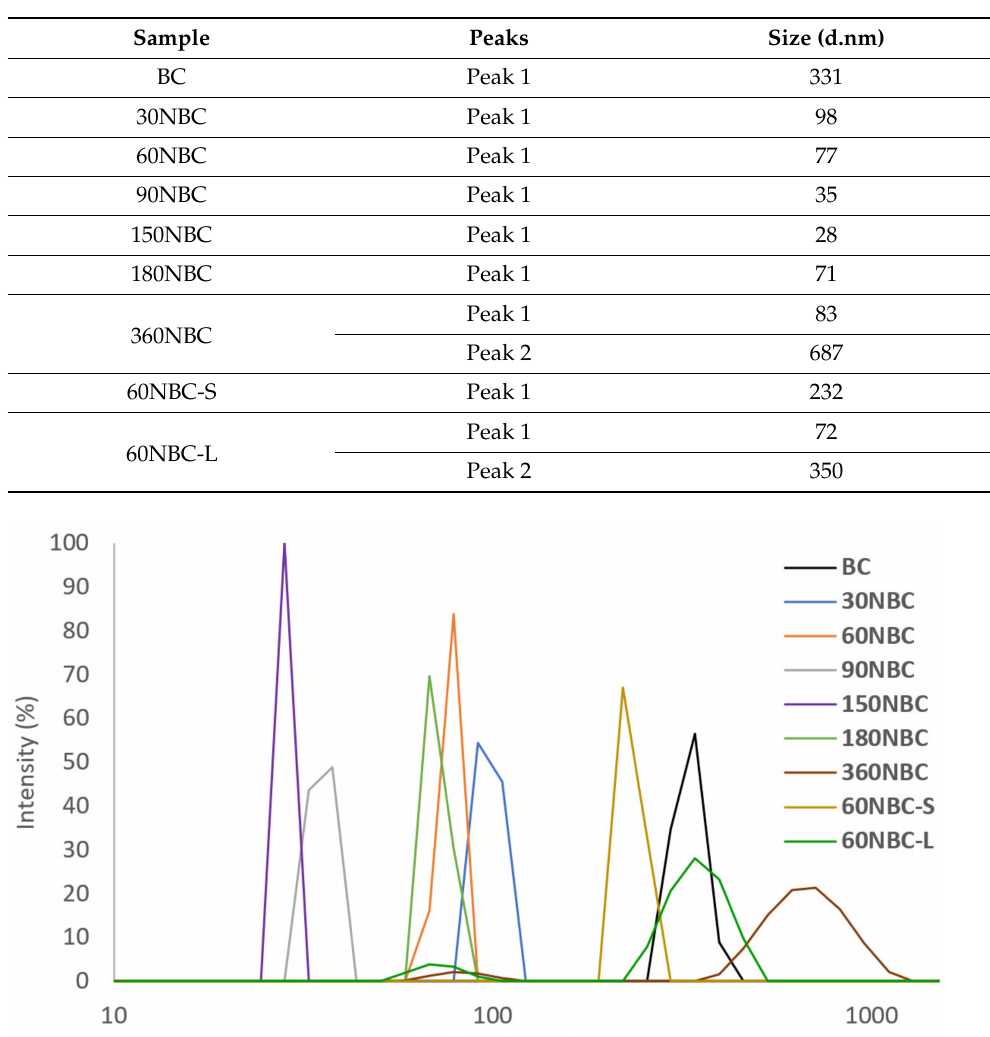
Table 2. The effect of the milling duration on the particle size of the nanobiochar. High-energy ball milling was performed using grinding media of mixed sizes.